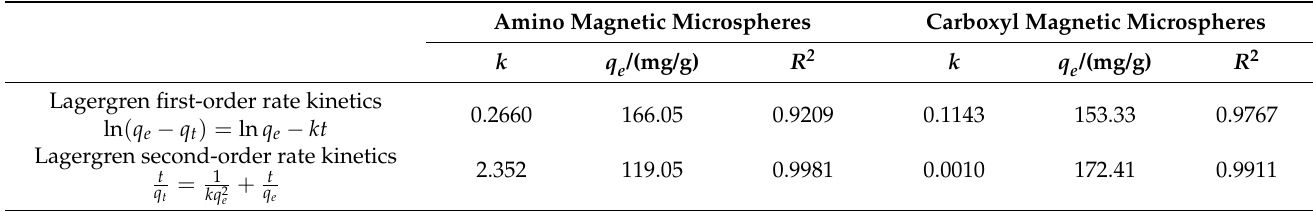
Table 3. Adsorption kinetics parameters of HB by amino magnetic microspheres and carboxyl magnetic